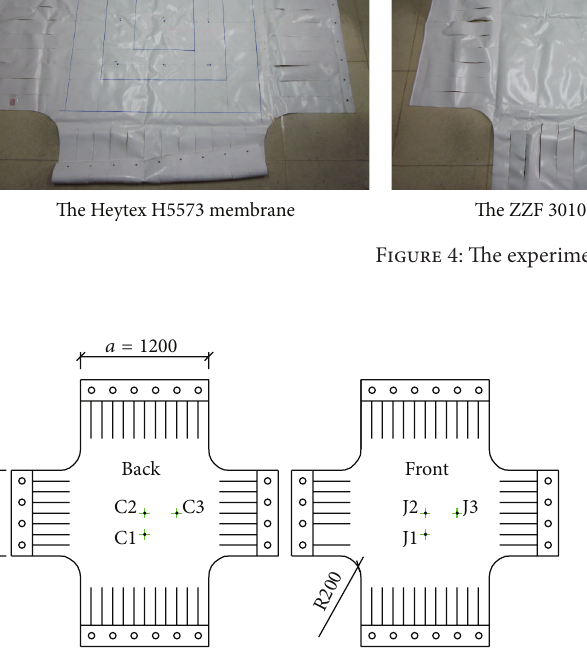
Figure 5: The shape and size of the experimental membrane.